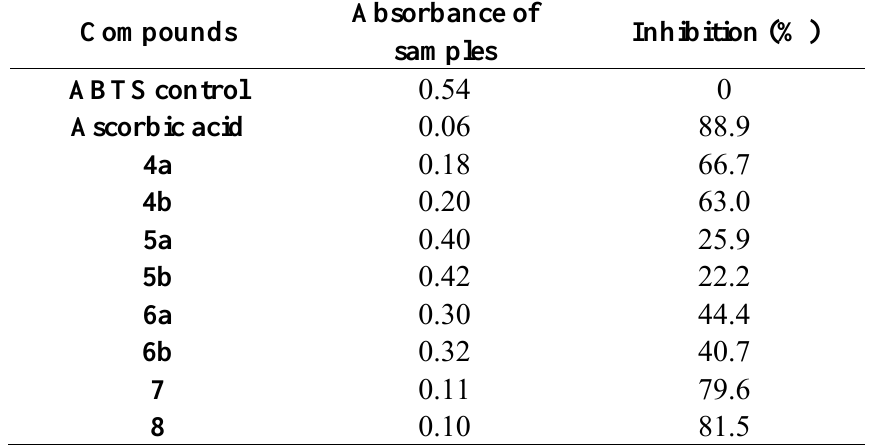
Table 3. Anti-oxidant assays by ABTS method [Abs. (control) − Abs. (test)/Abs. (control) × 100].